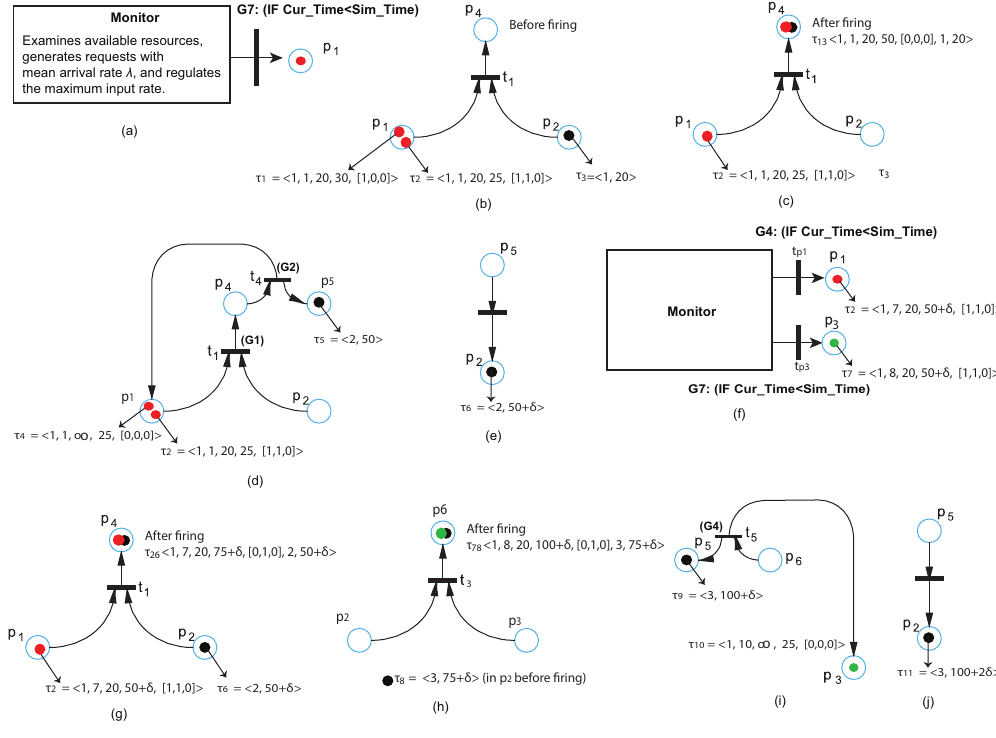
Figure 6. Simulation execution